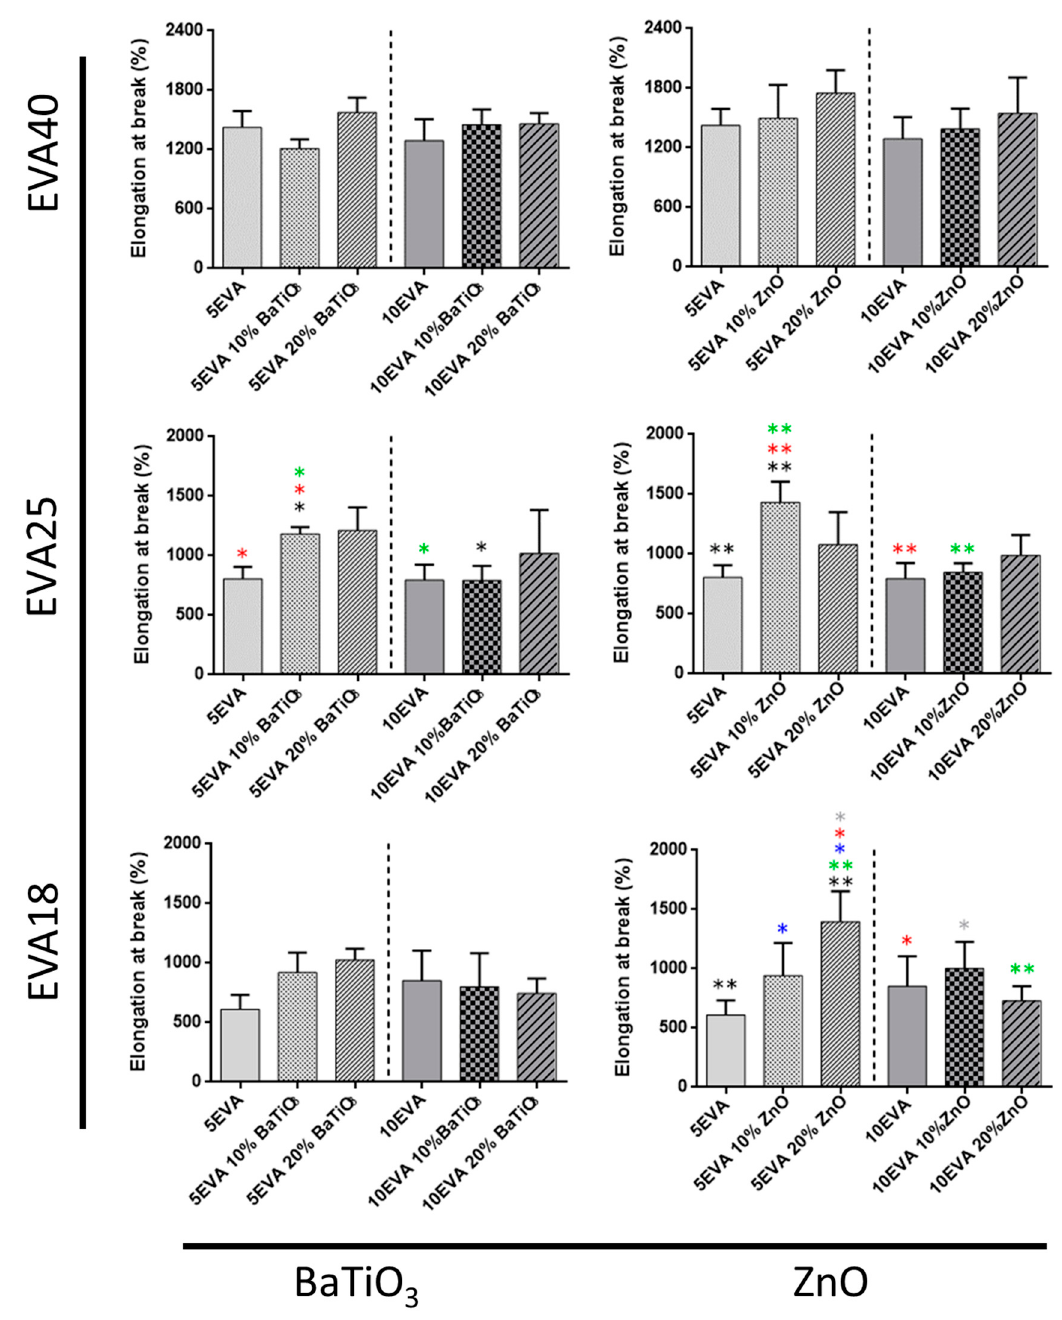
Figure 6. Elongation at break of nanocomposite EVA-based matrices subdivided for the content of vinyl acetate and the ceramic nanomaterial included. * = p < 0.05, ** = p < 0.01. Different colors have been used to evidence the statistical significance between the compared cases in each graph.